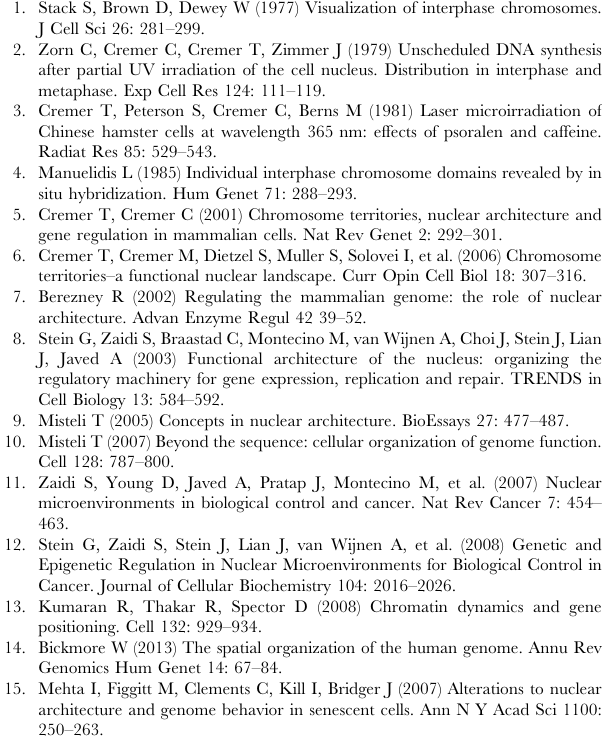
written in magenta. The values are color coded on a color-scale from low (red) to high (green). Table S5 Chi-square values comparing the overall patterns between cell types within G1 or S. The chi-square p values are shown comparing the overall patterns in WI38 to 10A in G1 and in S and comparing random simulations of WI38 and 10A. yellow p , 0.01, red p , 0.001. Table S6 Chi-square values for individual CT pairs between cell types. The chi-square p values are shown comparing WI38 to 10A for each individual CT pair in G1 and in S for differences in the percent of cells with only 1 interaction, $ 2 interactions, and when considering both = 1 $ 2 interactions together. Purple p , 0.10, Green p , 0.05, yellow p , 0.01, red p , 0.001. Dataset S1 Distance and volume measurements for CT and